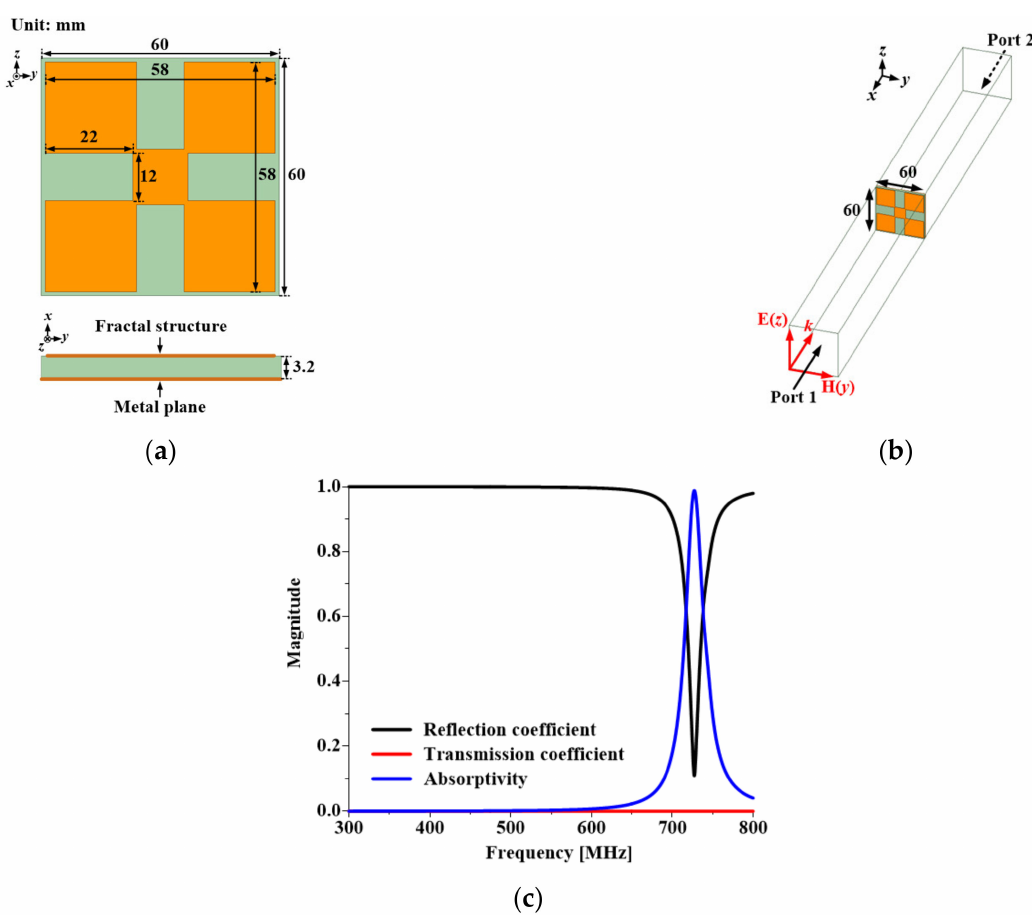
Figure 13. Basic unit cell of fractal absorber: ( a ) geometry of basic unit cell, ( b ) simulation setup, and ( c ) simulated S-parameters and